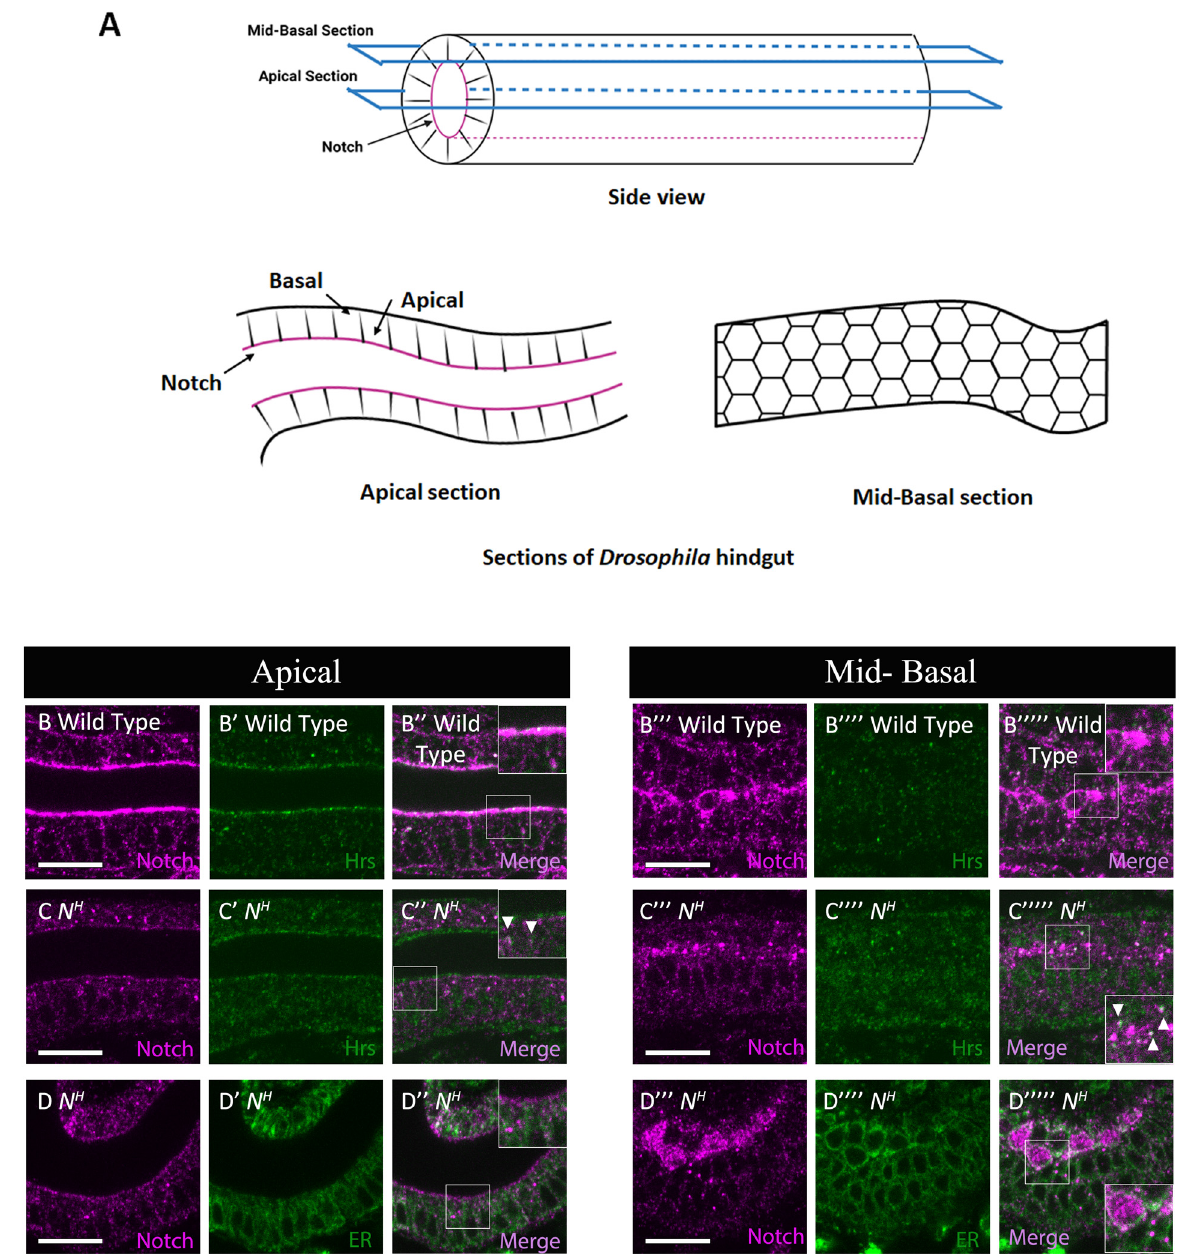
Figure 5. Notch accumulated abnormally in early endosomes of the hindgut epithelium in a Class II Notch mutant. ( A ) A diagram showing optical sections of the apical and mid-basal regions of the hindgut epithelium (Figures were made with the application from Biorender.com). The upper diagram shows the side view of the hindgut tube with apical and mid-basal sections, and the lower diagrams show the dorsal views of apical (left) and mid-basal (right) sections of the hindgut epithelium. The apical and mid-basal sections correspond to the microscopic images in ( B – D’’ ) and ( B’’’ – D’’’’’ ), respectively, as indicated in the top of ( B – D’’’’’ ). ( B – B’’’’’ ) In wild-type hindgut epithelium, Notch (magenta) and Hrs (green), a marker of early endosomes, were stained with an anti-Notch ( B , B’’ , B’’’ , B’’’’’ ) and anti-Hrs antibodies ( B’ , B’’ , B’’’’ , B’’’’’ ), respectively. ( C – D’’’’’ ) Hindgut epithelium in the N H hemizygote, a Class II Notch mutant, stained for Notch (magenta in C , C’’ , C’’’ , C’’’’’ , D , D’’ , D’’’ , D’’’’’ ), Hrs (green in C’ , C’’ , C’’’’ , C’’’’’ ), and Pdi-GFP, an ER marker (green in D’ , D’’ , D’’’’ , D’’’’’ ) were observed by anti-Notch, anti-Hrs, and anti-GFP antibody staining, respectively. Insets in ( B’’ , B’’’’’ , C’’ , C’’’’’ , D’’ , D’’’’’ ) are highly magnified images of regions outlined by white rectangles. White arrowheads point colocalized expression. All results were confirmed by staining biological triplicates. Scale bars: 10 μ m.